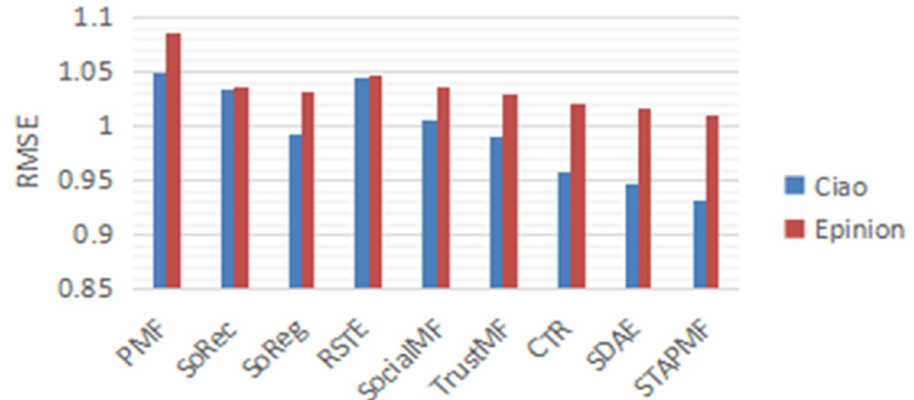
Fig 9. Comparison results on the different